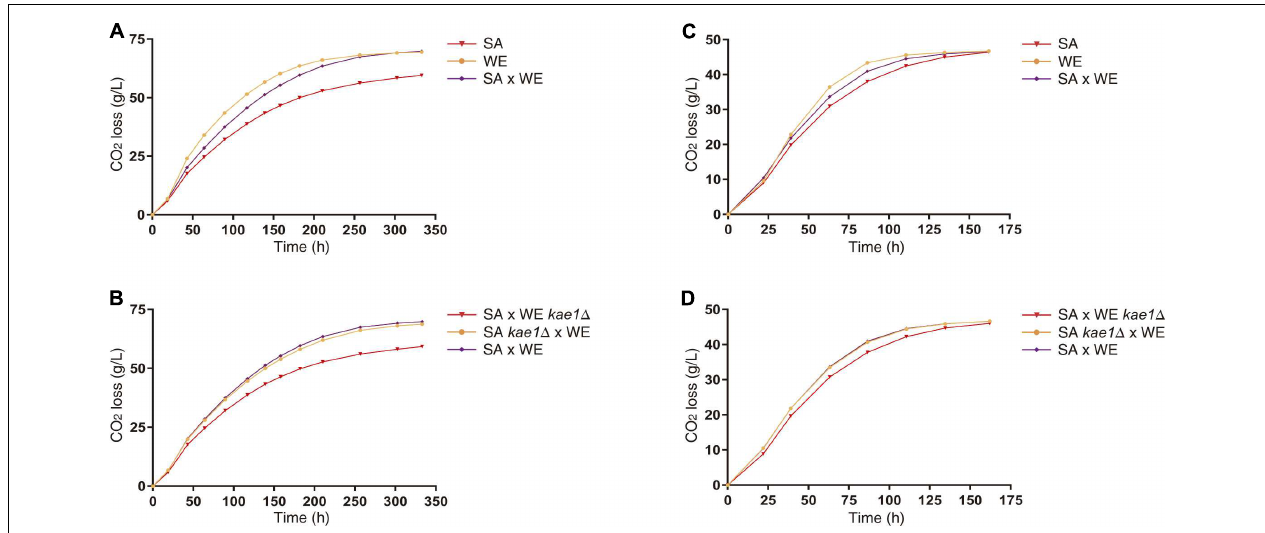
FIGURE 4 | Fermentation of parental and reciprocal hemizygous strains for KAE1 gene. The differences in CO 2 loss between parental strains (A,C) and reciprocal hemizygous strains (B,D) for the KAE1 gene were evaluated in microscale fermentations in SM60 (A,B) and SM300 (C,D) . Plotted values correspond to the average of three biological replicates, with their standard error represented by bars (mean ±